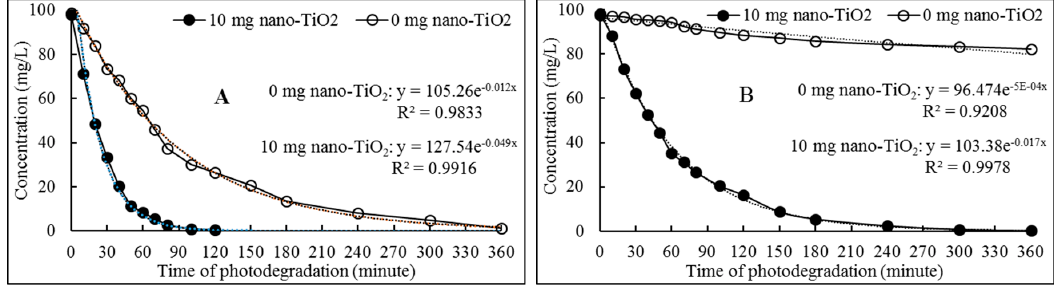
Figure 3. Kinetics of nano-TiO 2 mediated photodegradation of FTB under high-pressure mercury lamp ( A ) and under xenon lamp ( B ) irradiation.